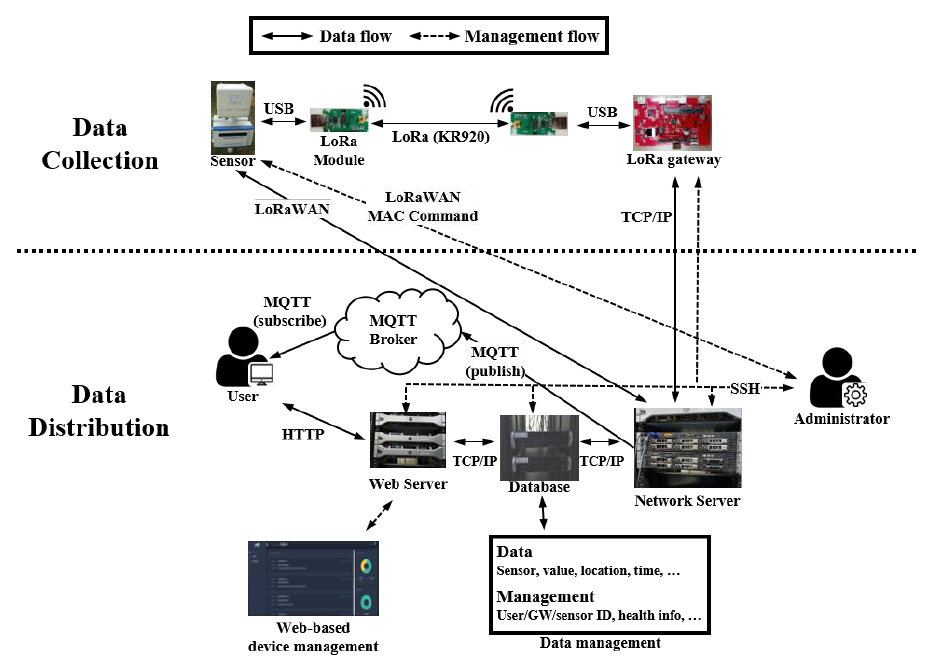
Figure 7. Network and management protocols for